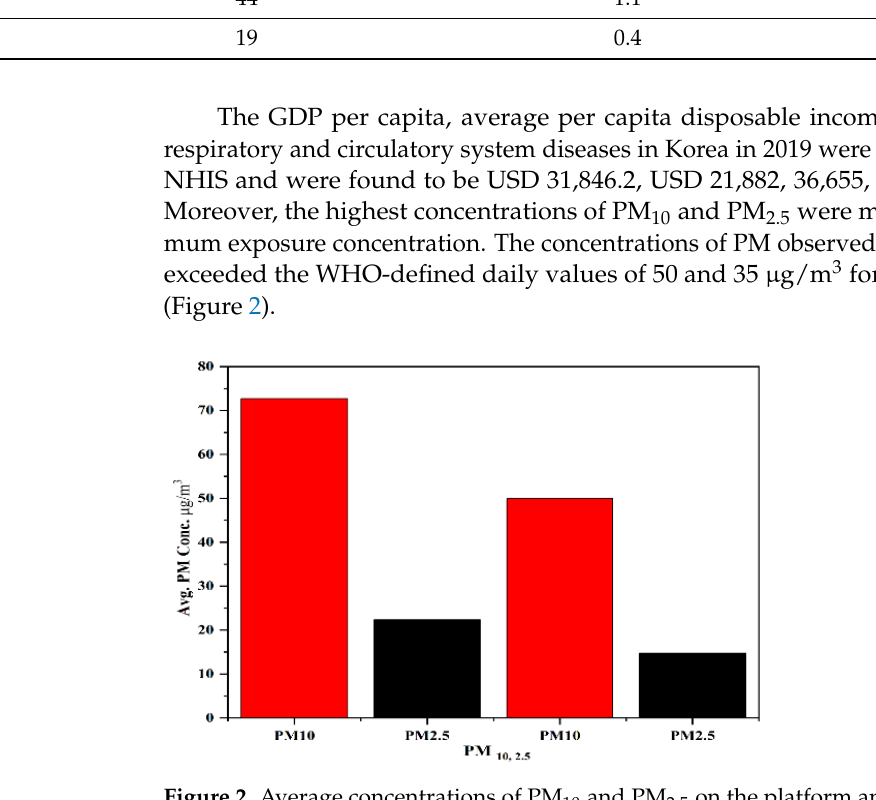
Figure 2. Average concentrations of PM 10 and PM 2.5 on the platform and in the waiting room (the two bars on the left represent the values observed in the subway PM and the two bars on the right represent the value defined by WHO. Table 2. Burden of PM 2.5 per 1000 persons for each health effect endpoint.